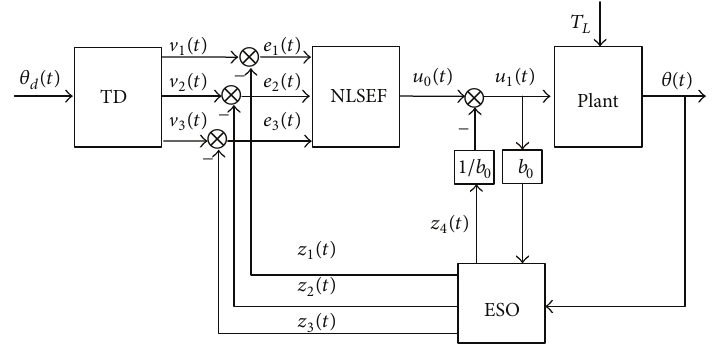
Figure 2: Schematics of ADRC.